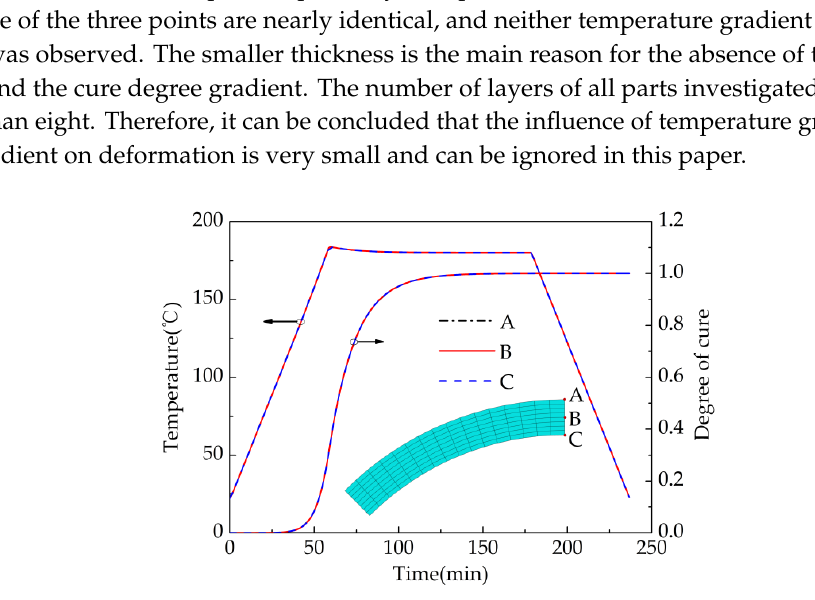
Figure 4. Finite element model of L-shaped parts: ( a ) without shear layer; ( b ) with shear layer.